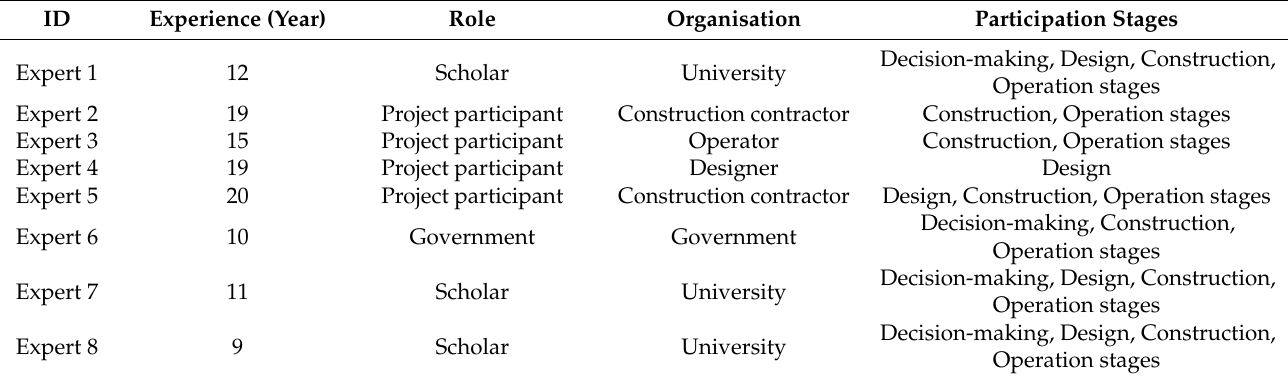
Table 1. Information about